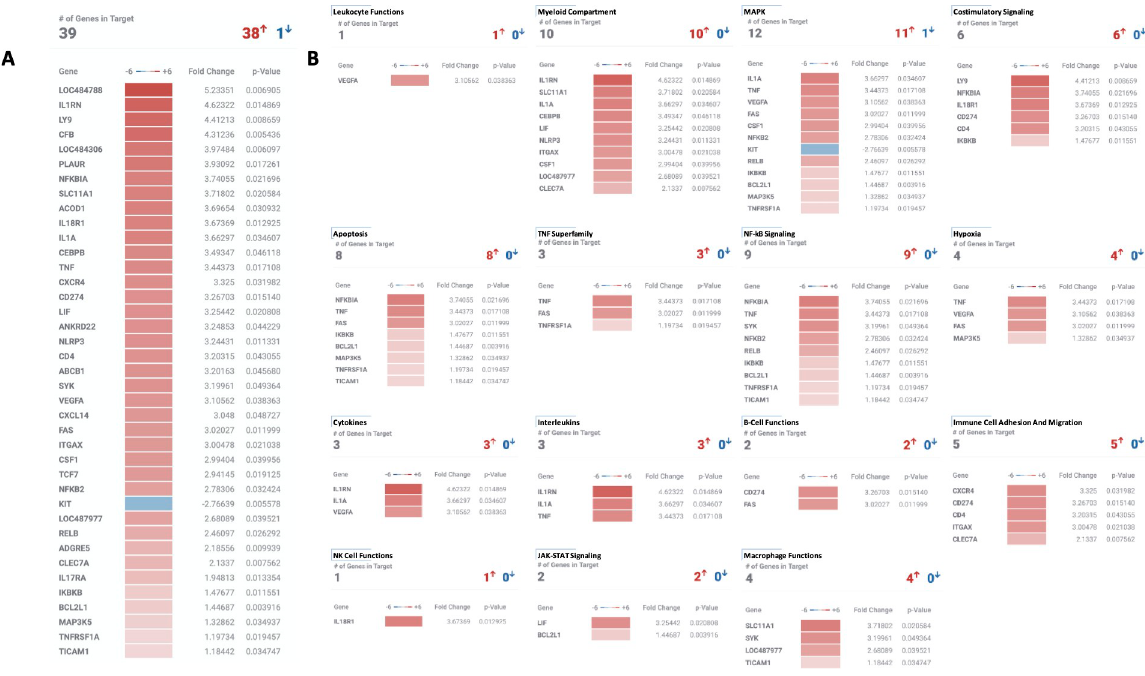
Fig 6. Differential canine immuno-oncology gene expression at day 13 post initiation of therapy. (A) Overall, 38 genes had significantly increased expression and 1gene had significantly decreased expression compared to pretreatment samples. (B) Clustering of differential gene expression changes by biologically relevant immuno-oncology